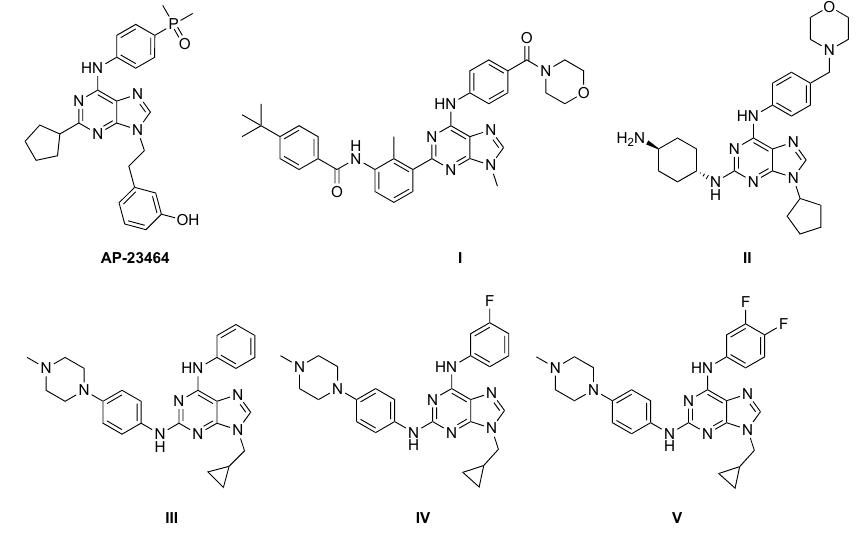
Figure 2. Some examples of purine derivatives reported as TKIs inhibitors.